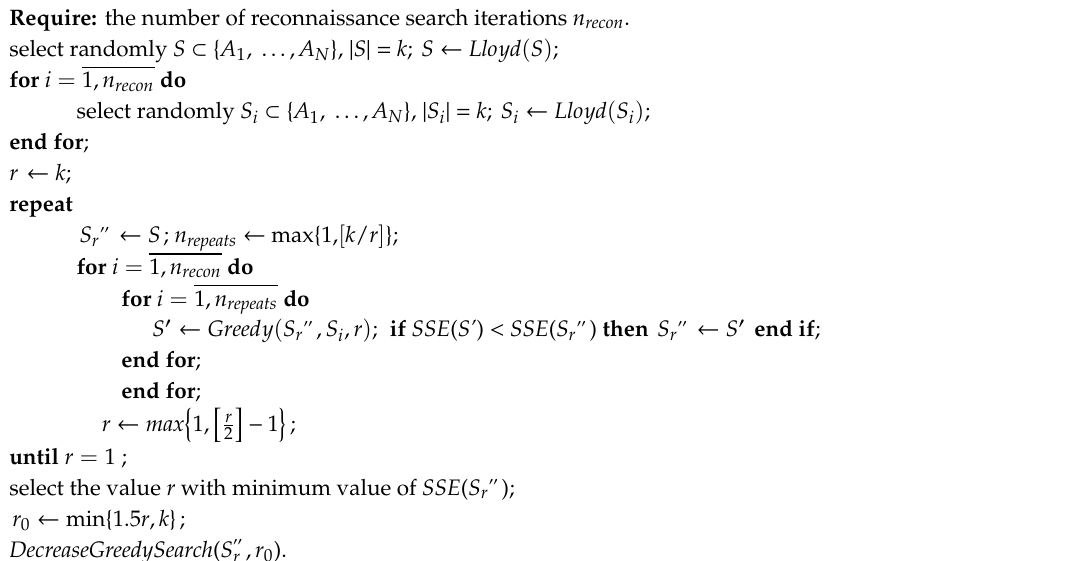
Algorithm 7. AdaptiveGreedy ( S )